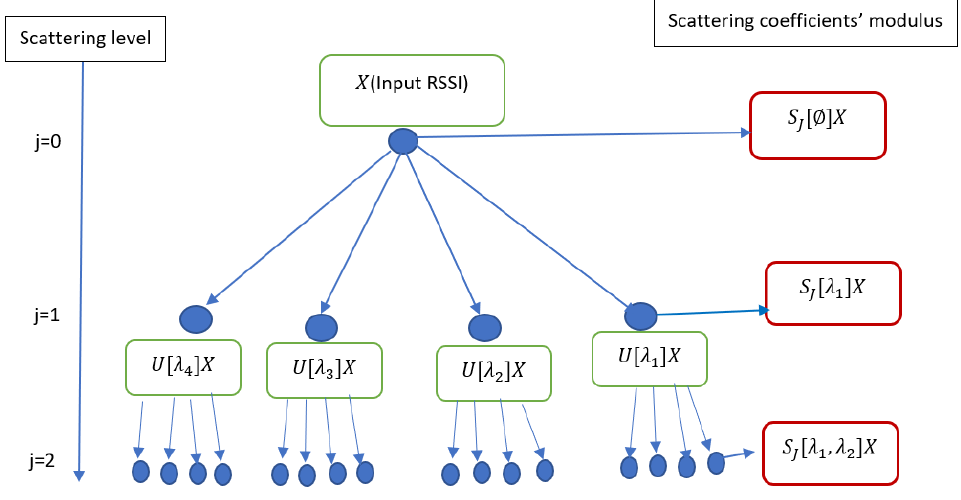
Figure 4. Wavelet scattering decompossition.